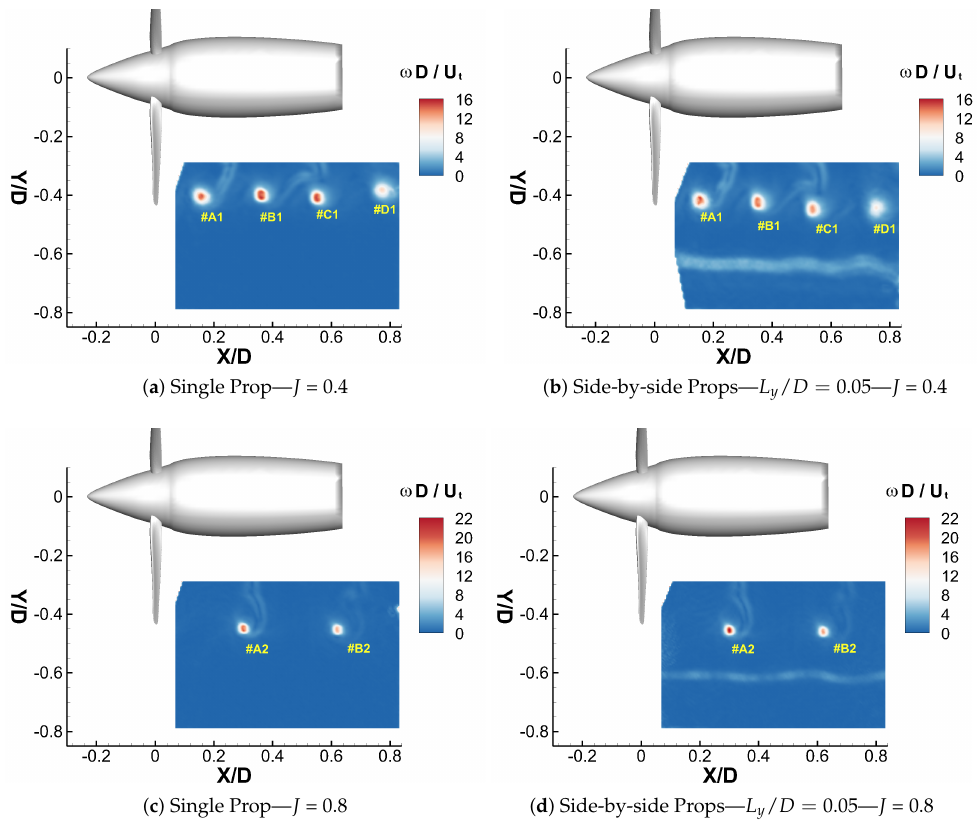
Figure 8. Comparison of the phase-averaged non-dimensional vorticity magnitude ω D / U t contours at blade azimuthal angle ψ = 90 ◦ , Re D = 1.96 × 10 6 , M t =